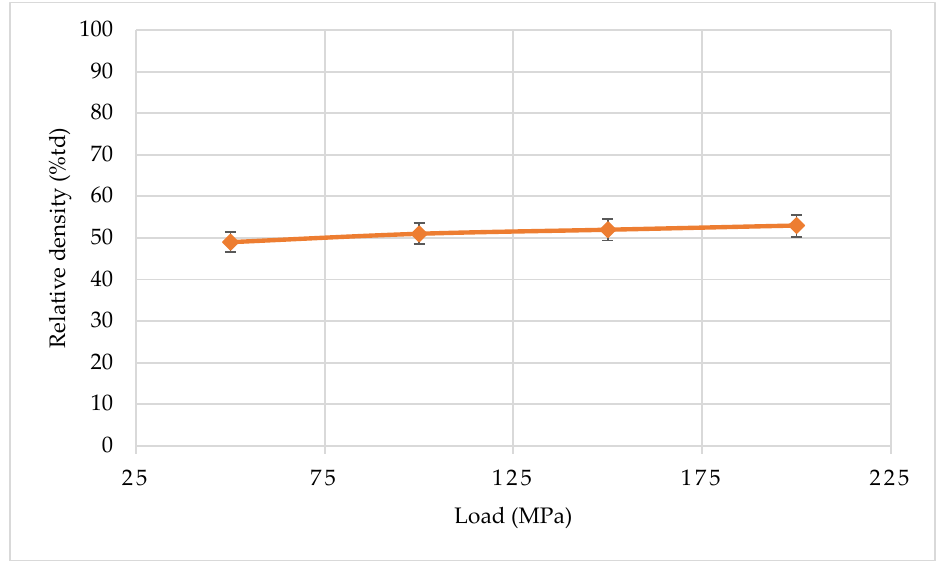
Figure 3. Impact of pressing pressure on density of WC-Co.